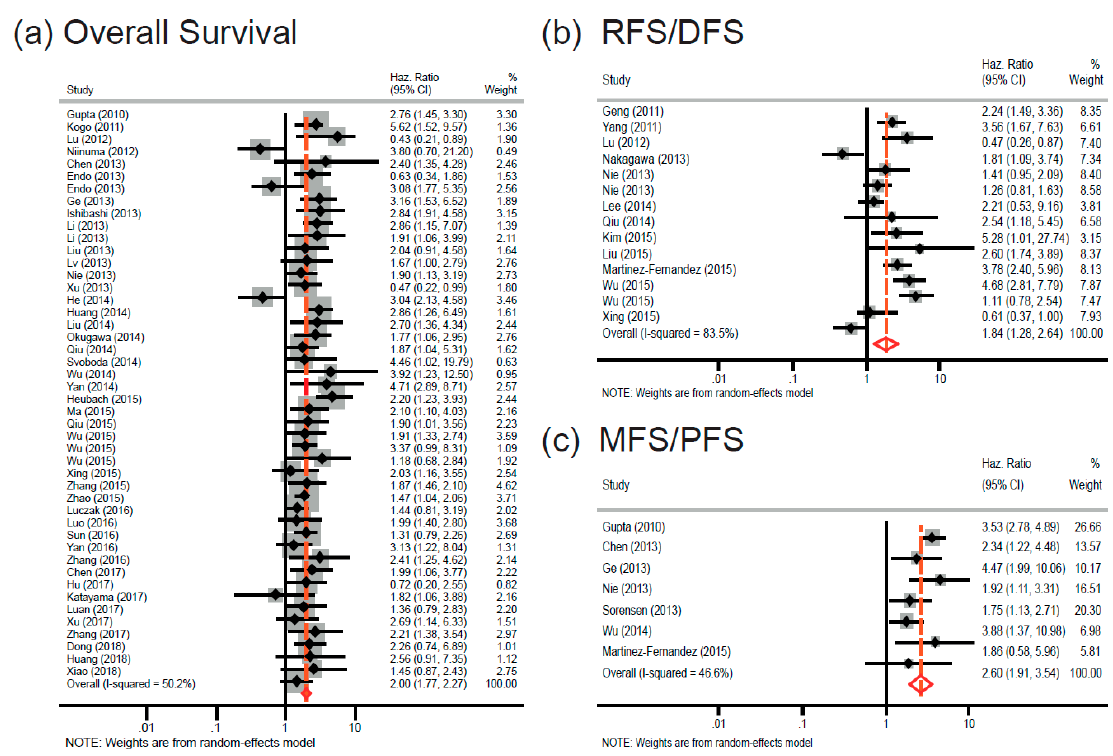
Figure 2. Forest plots of combined analyses on the association of survival with HOTAIR expression. ( a ) Forest plot of OS analysis, ( b ) forest plot of RFS / DFS analysis, and ( c ) forest plot of MFS / PFS analysis. Abbreviations: HR, Hazard ratio; OS, overall survival; RFS, recurrence-free survival; DFS, disease-free survival; MFS, metastasis-free survival; and PFS, progression-free survival.